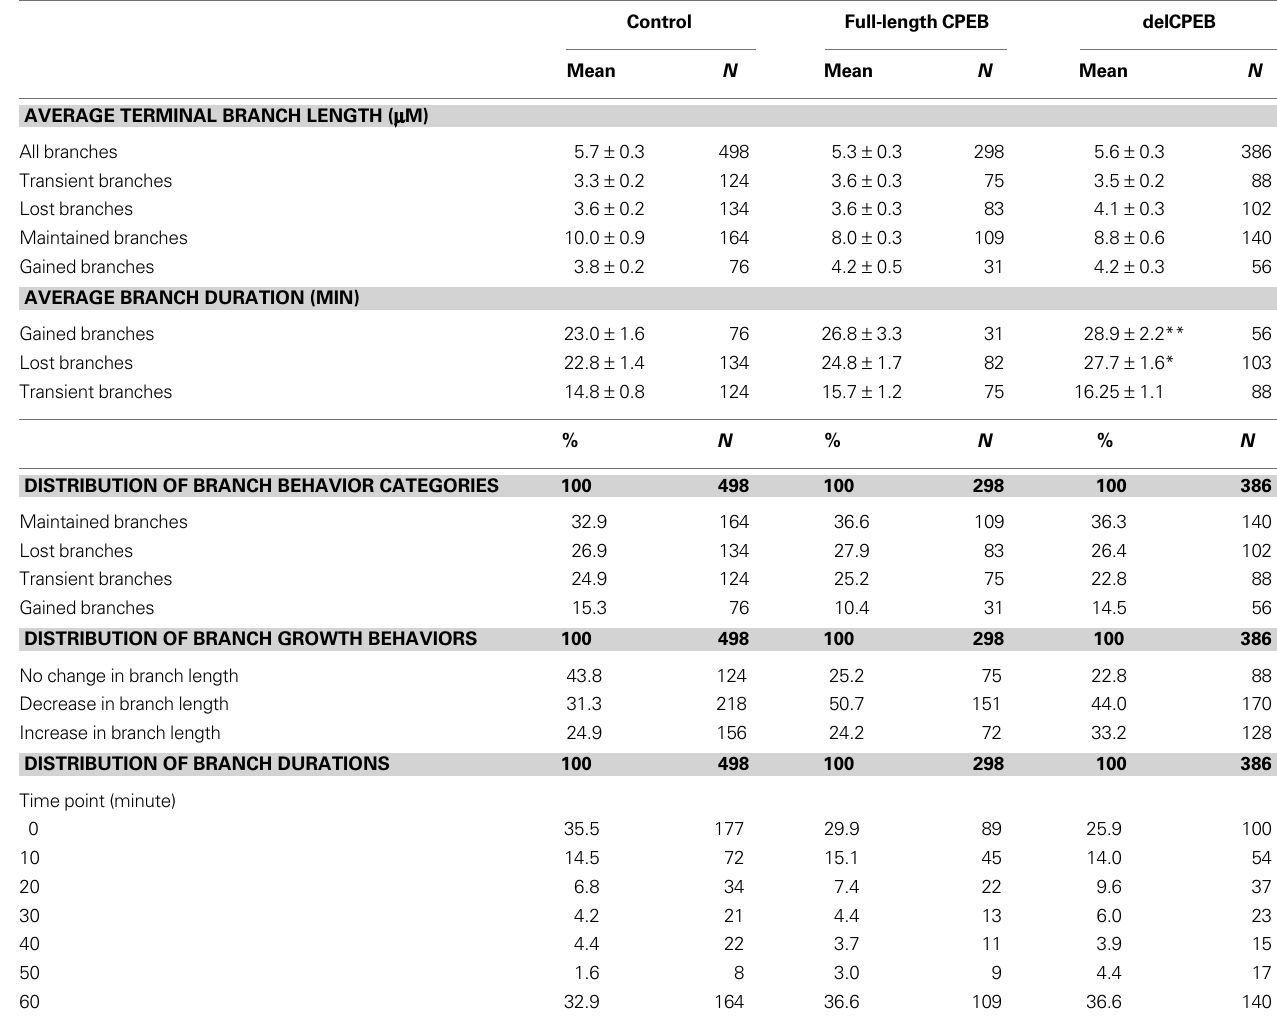
Table 2 | Characteristics of terminal branches and their branch